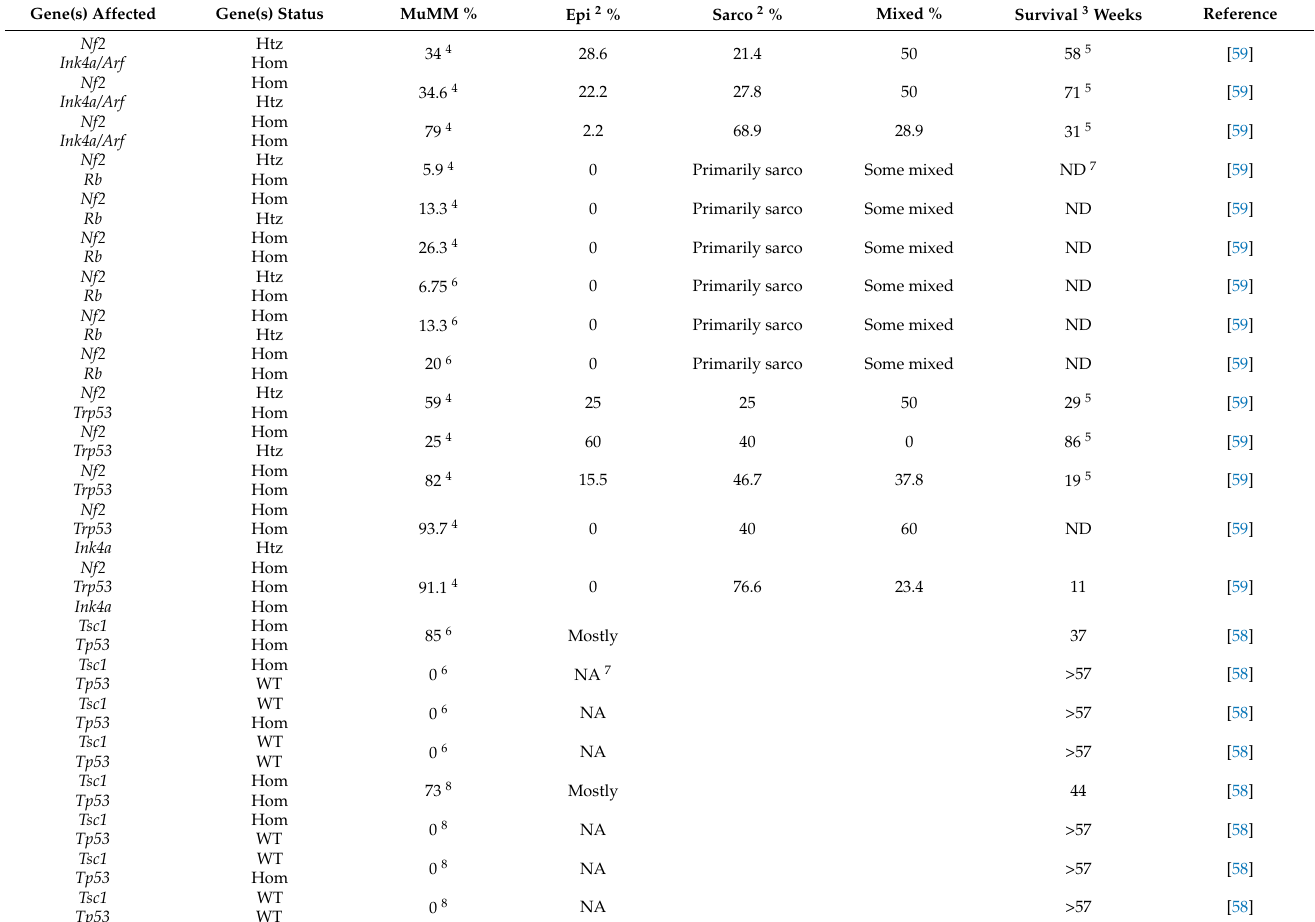
Table 1. Induction of murine mesotheliomas (MuMM) in genetically engineered mice (GEM) (Injection of Ad Cre in GEM 1